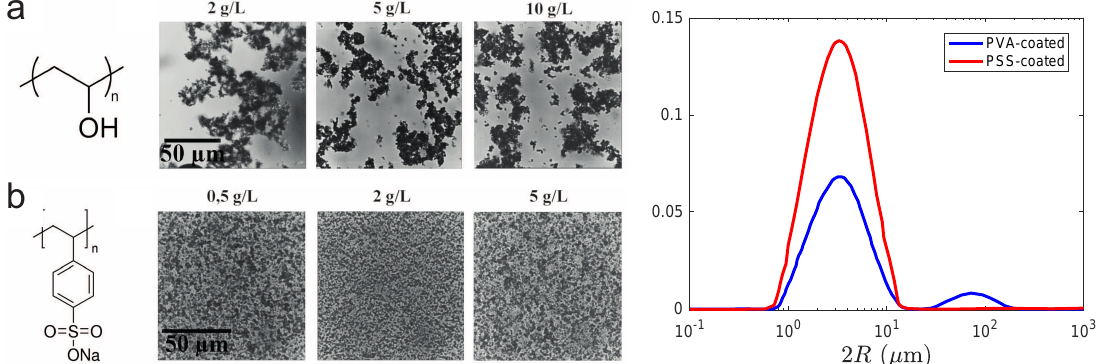
Figure 1. Left : ( a ) chemical formula of poly(vinyl alcohol) (PVA) and pictures of formulations containing calcite and PVA (concentration given above the image); ( b ) chemical formula of poly(sodium 4-styrenesulfonate) (PSS) and pictures of formulations containing calcite and PSS. In both cases, the mass fraction of calcite is 2%. Right : size distribution of CaCO 3 powders in water with PSS or PVA (2% w / w of particles in a 2 g · L − 1 PVA or PSS solution).